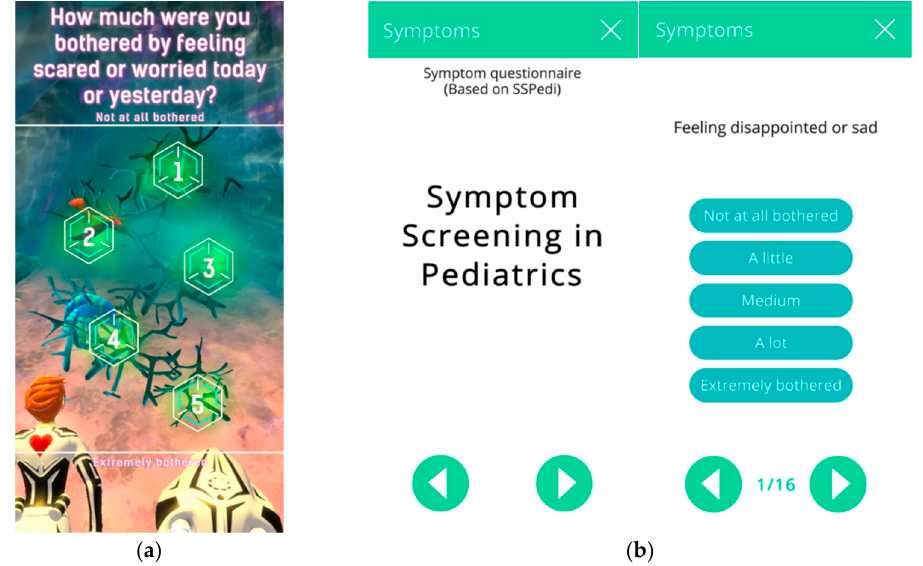
Figure 1. ( a ) Example of a question appearing in the MyPal Child App serious game; ( b ) example of a symptom question appearing in the MyPal Carer App, to be answered by proxy.